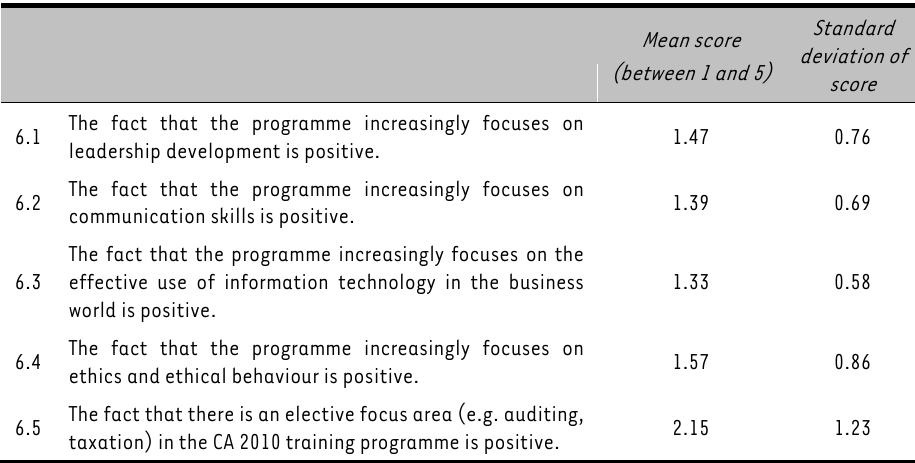
Perceptions regarding the value of the main changes